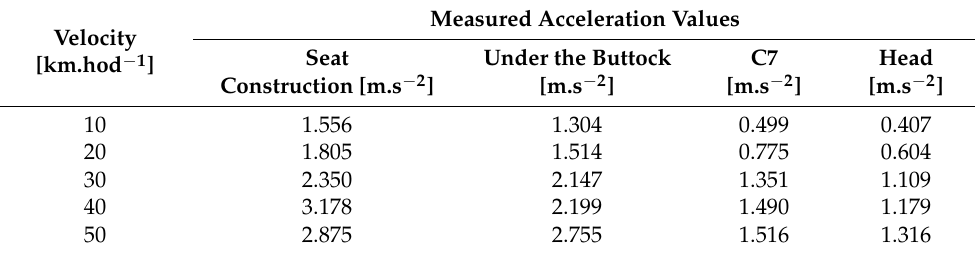
Table 2. Average values of accelerations for driver-variants V1 to